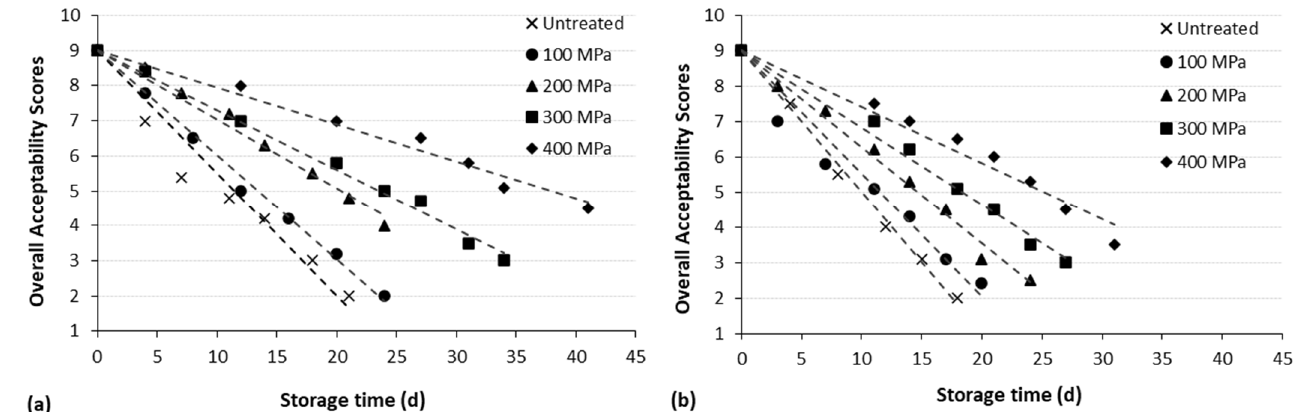
Figure 6. Overall acceptability scores of cooked untreated and HP-treated sea bass fillets at ( a ) 100–